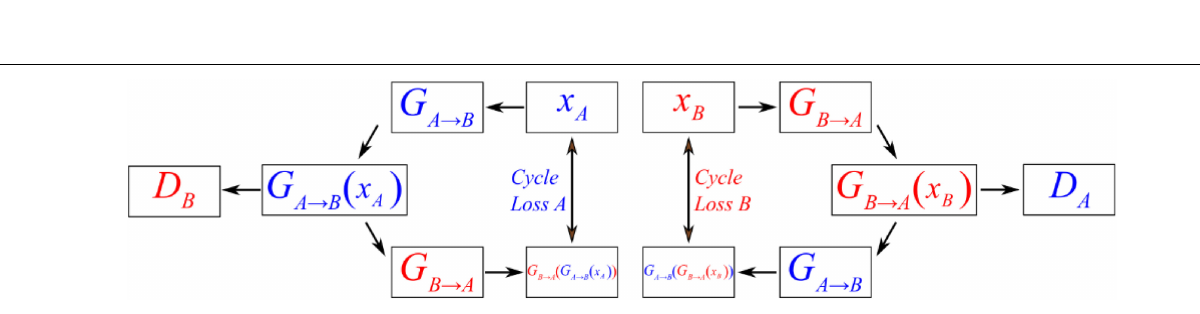
FIGURE 4 | Schematic diagram showing the operating principles between the generator and discriminator of CycleGAN.